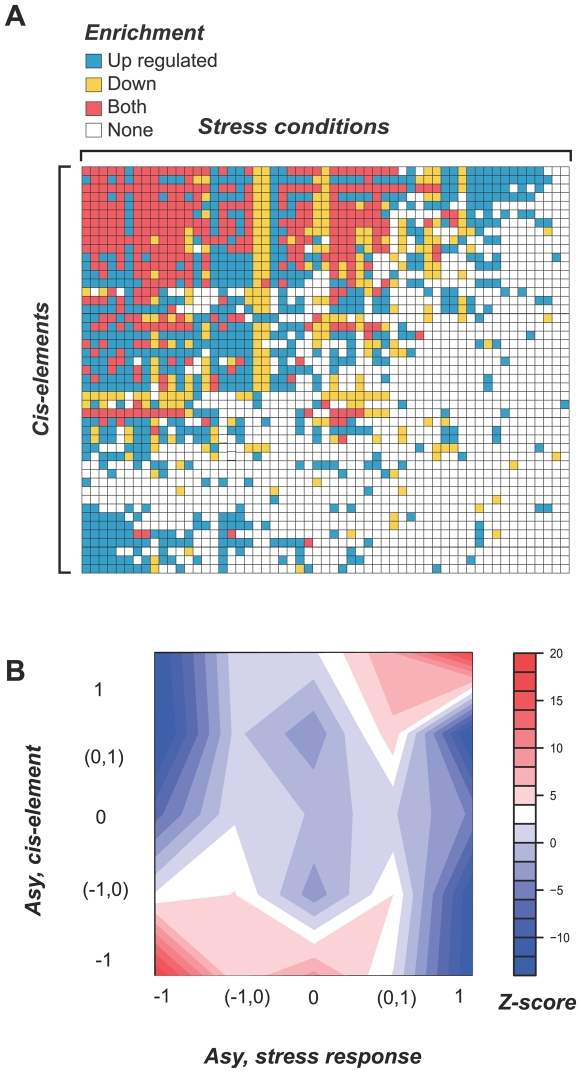
Correlation between stress response and cis-regulatory evolution.(A) Enrichment of putative cis-elements in the putative promoter regions of stress responsive genes under different conditions (includes different time points for each treatment, e.g., drought 3 hr, drought 6 hr, etc.). Significant enrichment of a particular cis-element in the promoters of up-regulated, down-regulated, or both up- and down-regulated genes is indicated by blue, yellow, and red, respectively. No significant enrichment under a condition is indicated by a white box. (B) Contour plot illustrating the positive correlation between stress response and putative cis-element asymmetries. Cis-element Asy is defined in the same way as for stress response partitioning (Figure 5A) except that, presence (1) or absence (0) of a putative cis-element was used in place of up-regulation (1) and no change (0). For a particular duplicate pair, we randomly assigned index 1 and 2 to the duplicates, so that when we calculated asymmetry score (Asy, Figure 5A) for partitioning of responsiveness and cis-elements, the subtractions were in the same direction. As a result, half of the time Asy is below zero. The observed number in each Asy value bin was compared to simulated datasets generated by random assignment of putative cis-elements among extant genes while fixing the number of genes with a particular element. The deviation of the observed numbers from random expectation was assessed by calculating the Z-score. Shades of red and blue indicate over and under-representation, respectively.